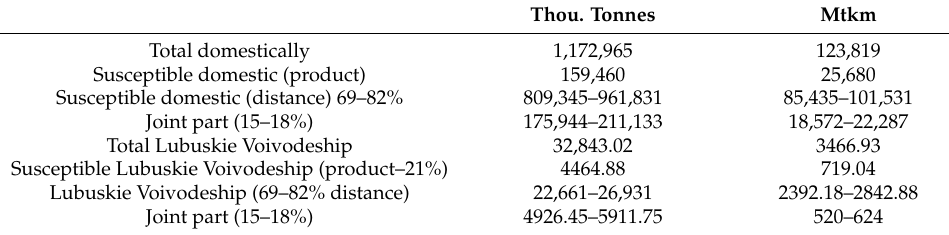
Table 2. Distribution of cargoes susceptible to a modal shift in